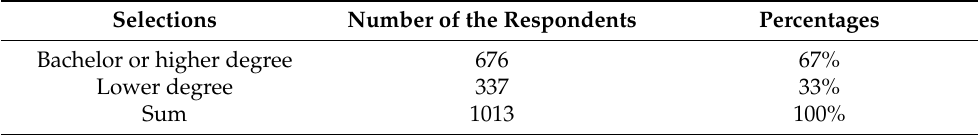
Table A4. Do you hold a bachelor or higher degree (single-choice question)?